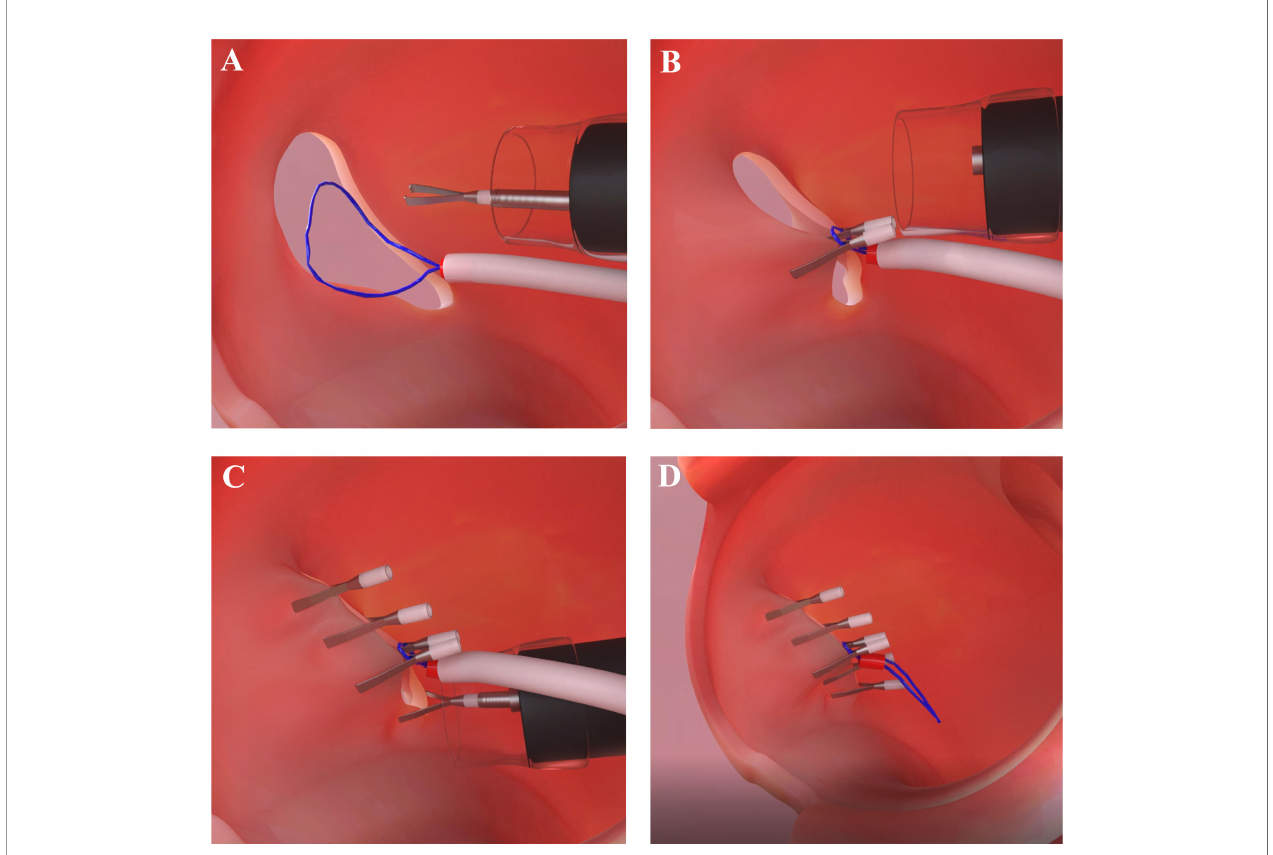
FIGURE 2 | Illustration of the ‘‘ Kissing Suture ’’ method. (A) Nylon loops along with endoclip is used to anchor the two edges of the defected wall. (B) Nylon loops is fi xed along with endoclip. (C) Additional clips are used to complete the linear incision closure. (D) Overview of the defect closure using nylon loops and